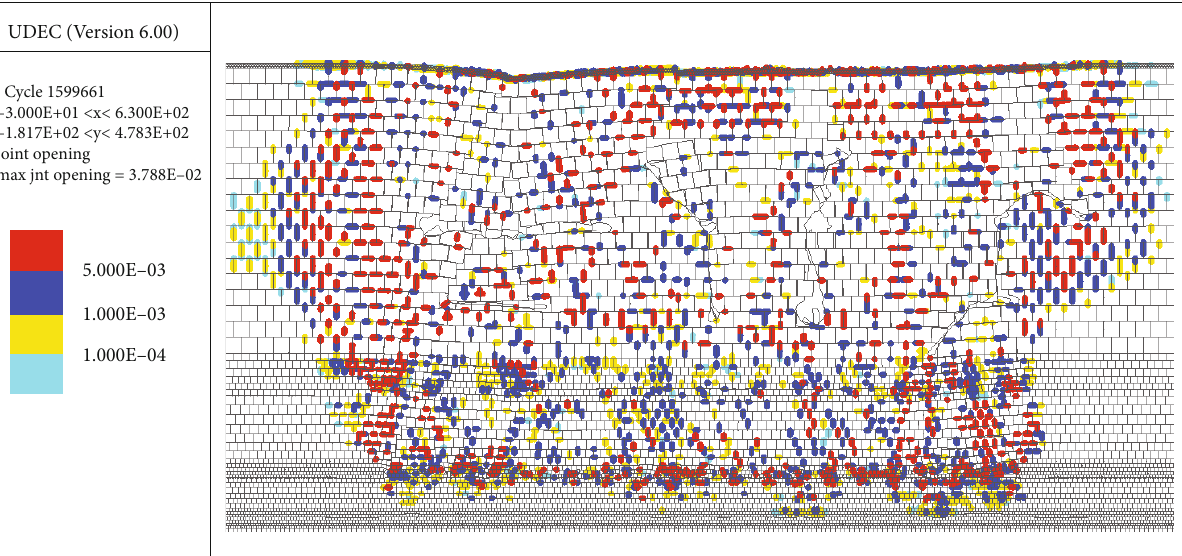
Figure 8: Mining-induced fracture fi eld (mining distance is 500 m in 4# coal Figure 7. The maximum opening of the overburden fracture is 49.27 mm. The fractures in the roof are mainly concen- trated at the front and rear ends of the stope, and the opening